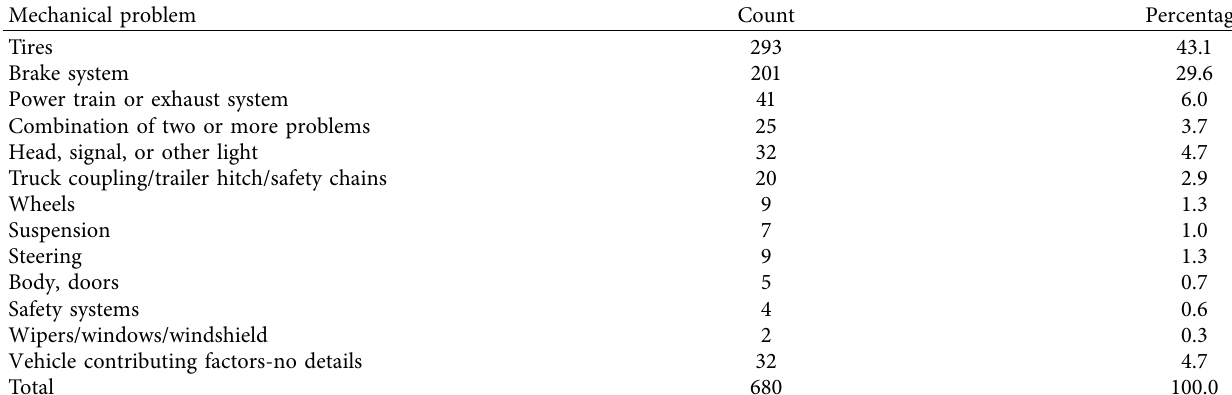
Table 2: Mechanical problems and distributions.